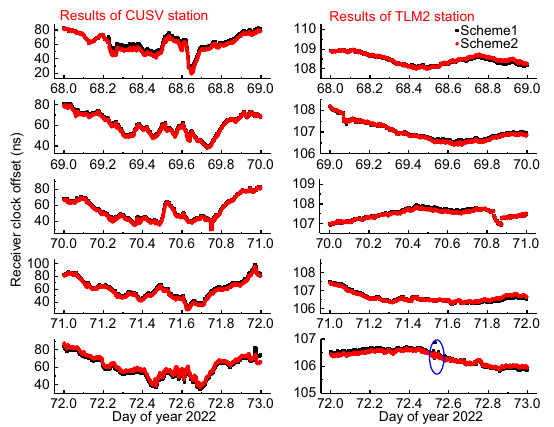
Fig. 10 CUSV and TLM2 receiver clock offsets from BDS-3/GPS PPP in